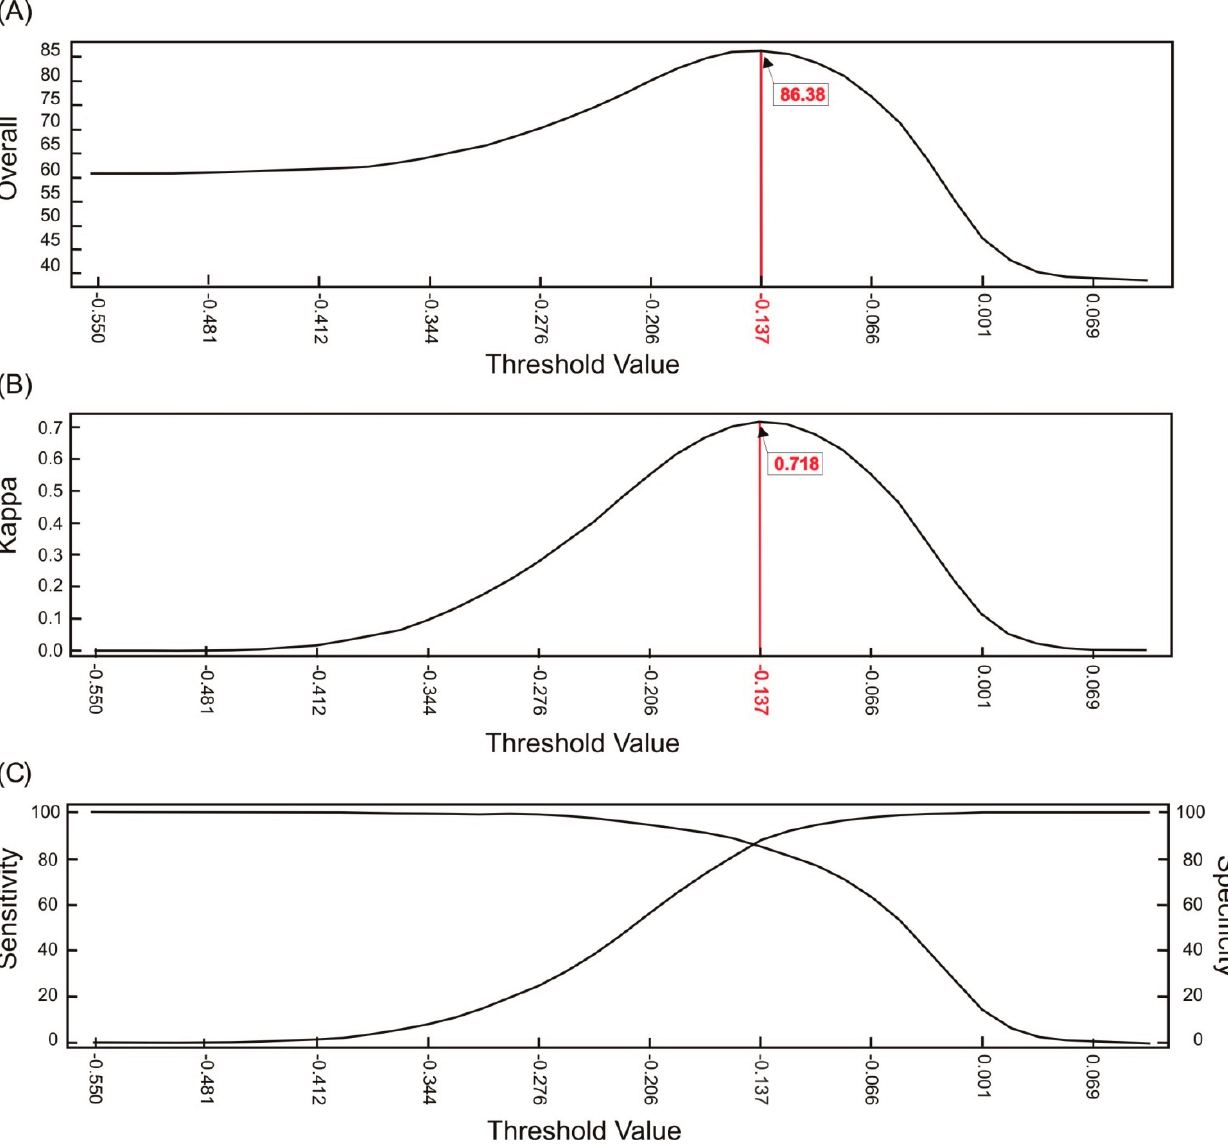
Figure 17. Identification of the optimal threshold values for burned-area detection from the deviation images using trimmed mean interannual phenology (alpha = 0.1). The accuracy assessment curves refer to the following indices: ( A ) Overall accuracy, ( B ) Kappa coefficient, and ( C ) Sensitivity-Specificity